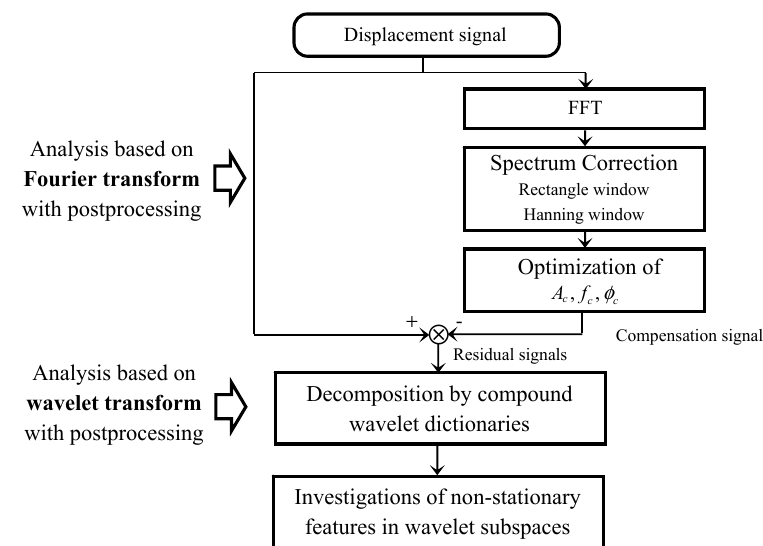
Figure 13. Flow chart of the proposed feature extraction method for displacement signals.